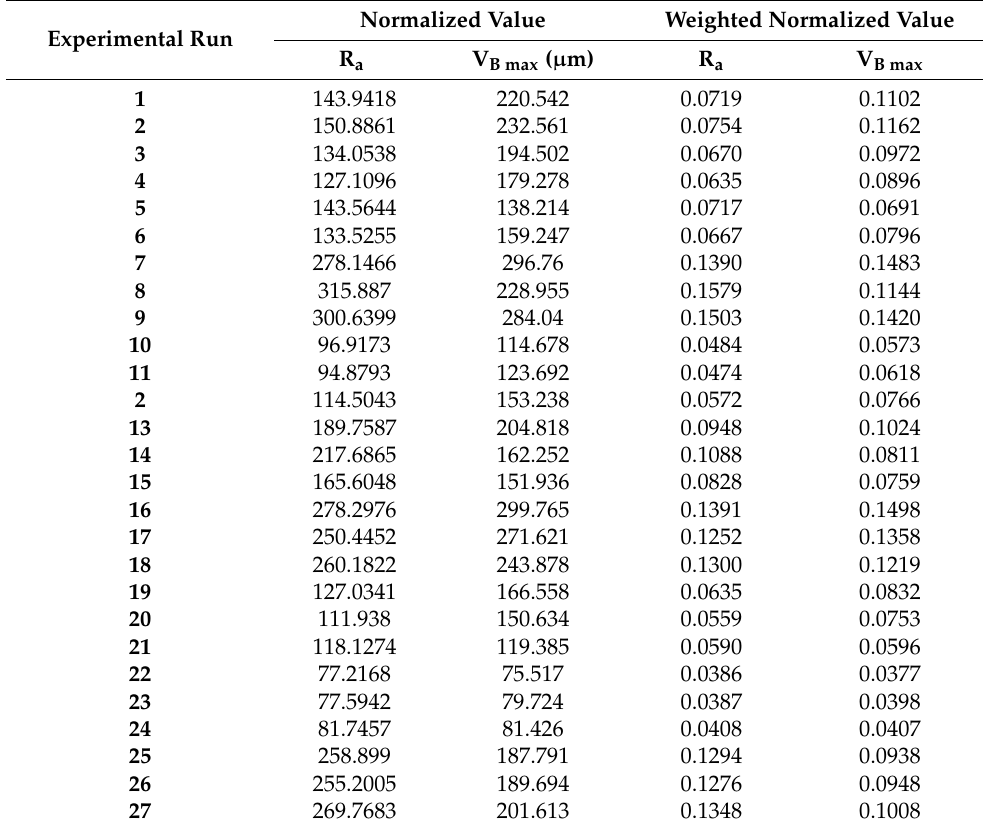
Table 5. Normalized weighted values of the